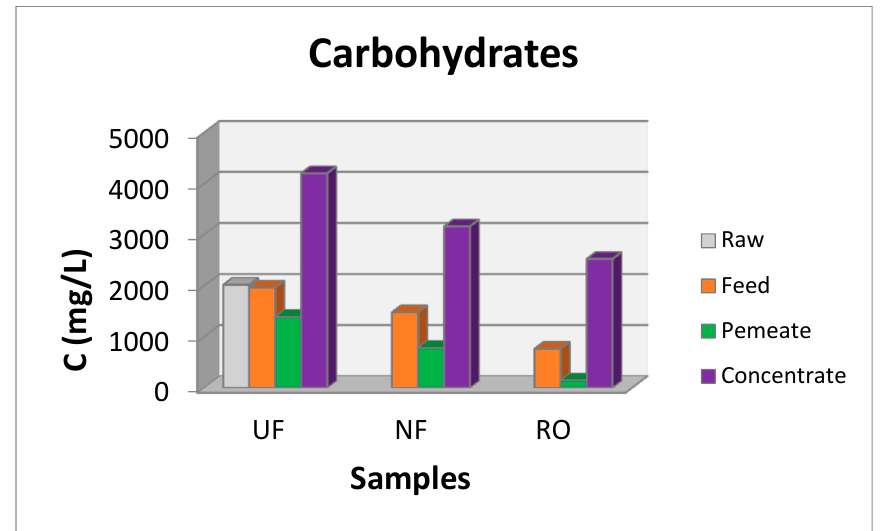
Figure 10. Carbohydrates concentration at the raw, feed, permeate, and concentrate streams at the UF, NF, and RO membranes.